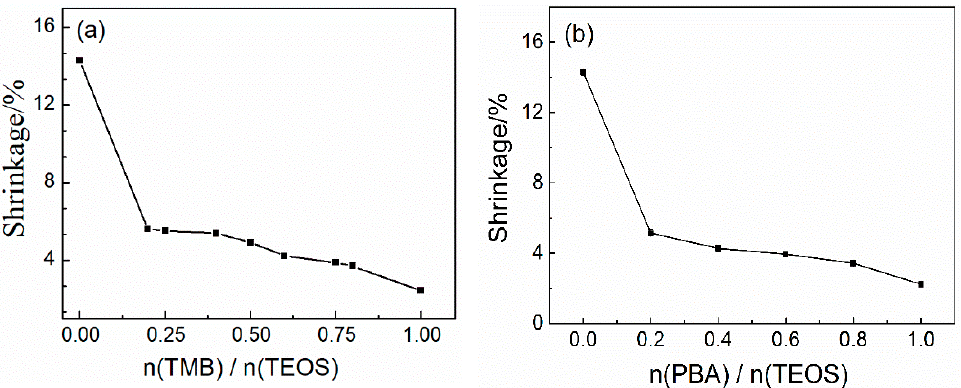
Figure 9. The shrinkage of the SiBCO aerogel composites with varying contents of TMB ( a ) and PBA ( b ) after heating in air at 1773 K for 30 min.